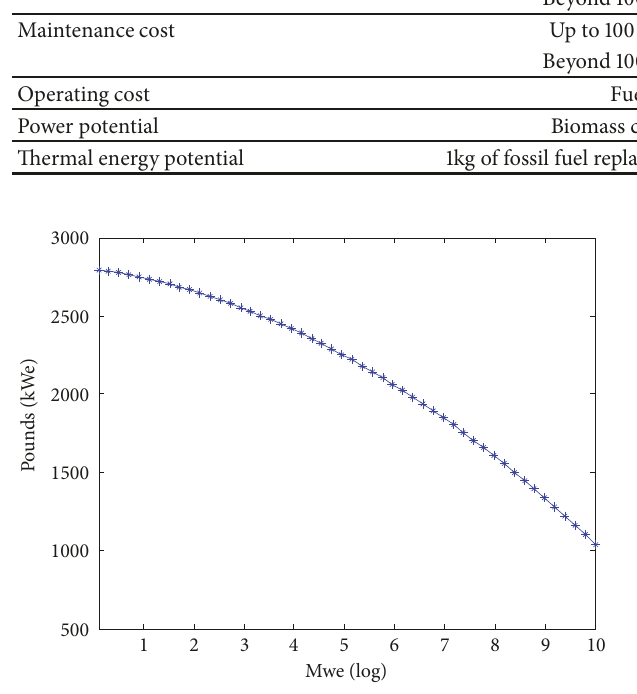
Figure8:Costofbuildingbiomassgasificationplant.Source:Hewitt